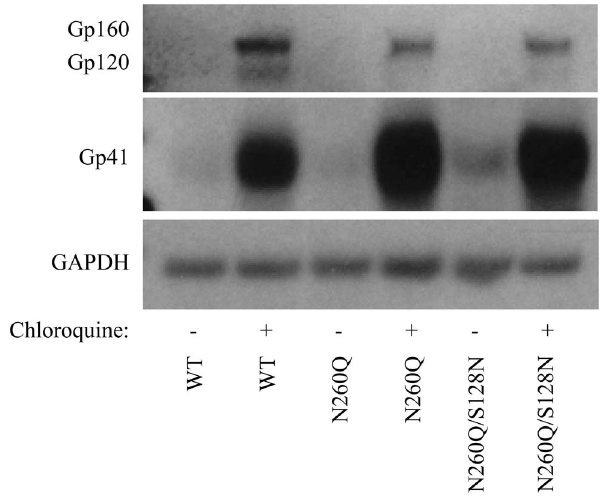
Figure 8. Western blot analysis of the expression levels of gp160, gp120 and gp41 in virus transfected HEK293T cells, in the absence or presence of the lysosomal inhibitor chloro- quine. WT, N260Q and N260Q/S128N virus transfected HEK293T cells were lysed and subjected to WB analysis (2 ng of p24 protein), to detect gp160, gp120 and gp41 in the cell lysates. GAPDH was used as an equal loading control.